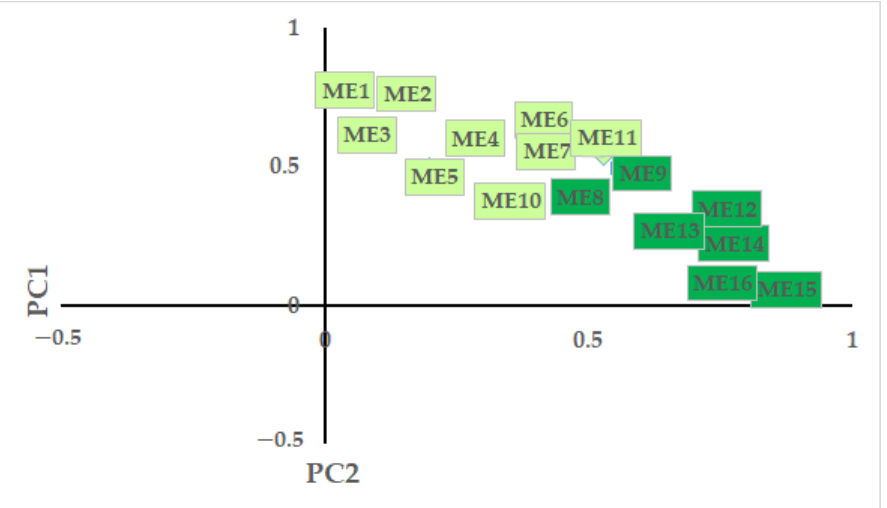
Figure 3. Results of the principal component analysis on responses regarding the acceptability of